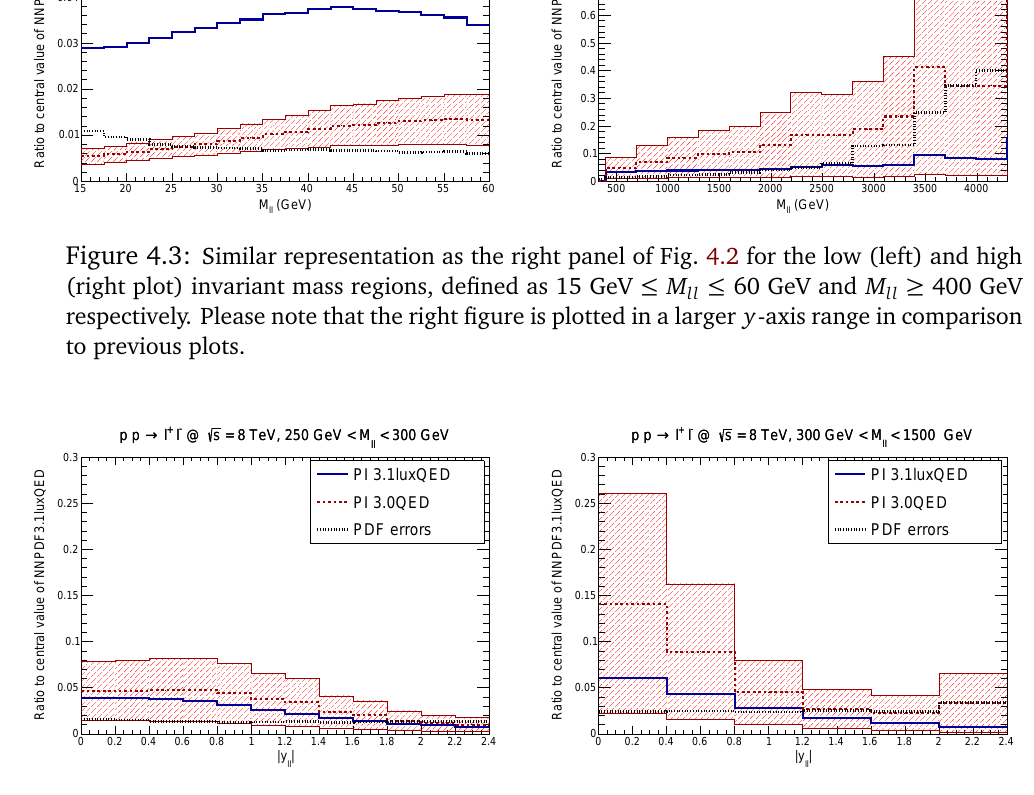
| in two different invariant ll ≤ 1500 GeV (lower ll